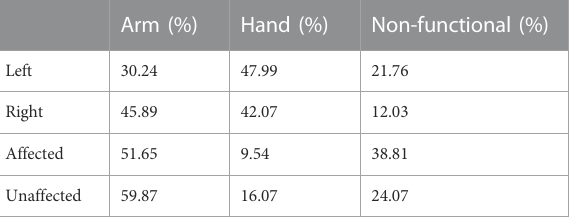
TABLE 4 Average proportion of data corresponding to the different